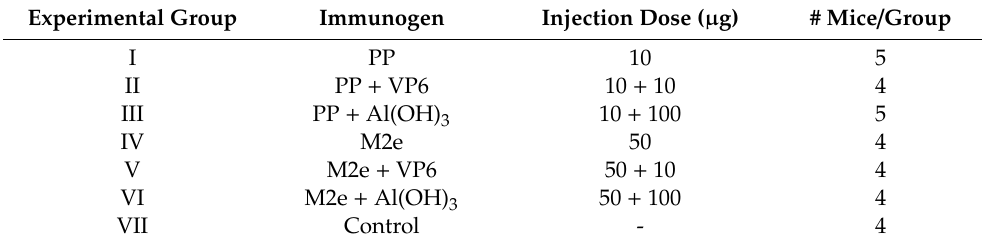
Table 1. Antigenic formulations and immunization of experimental